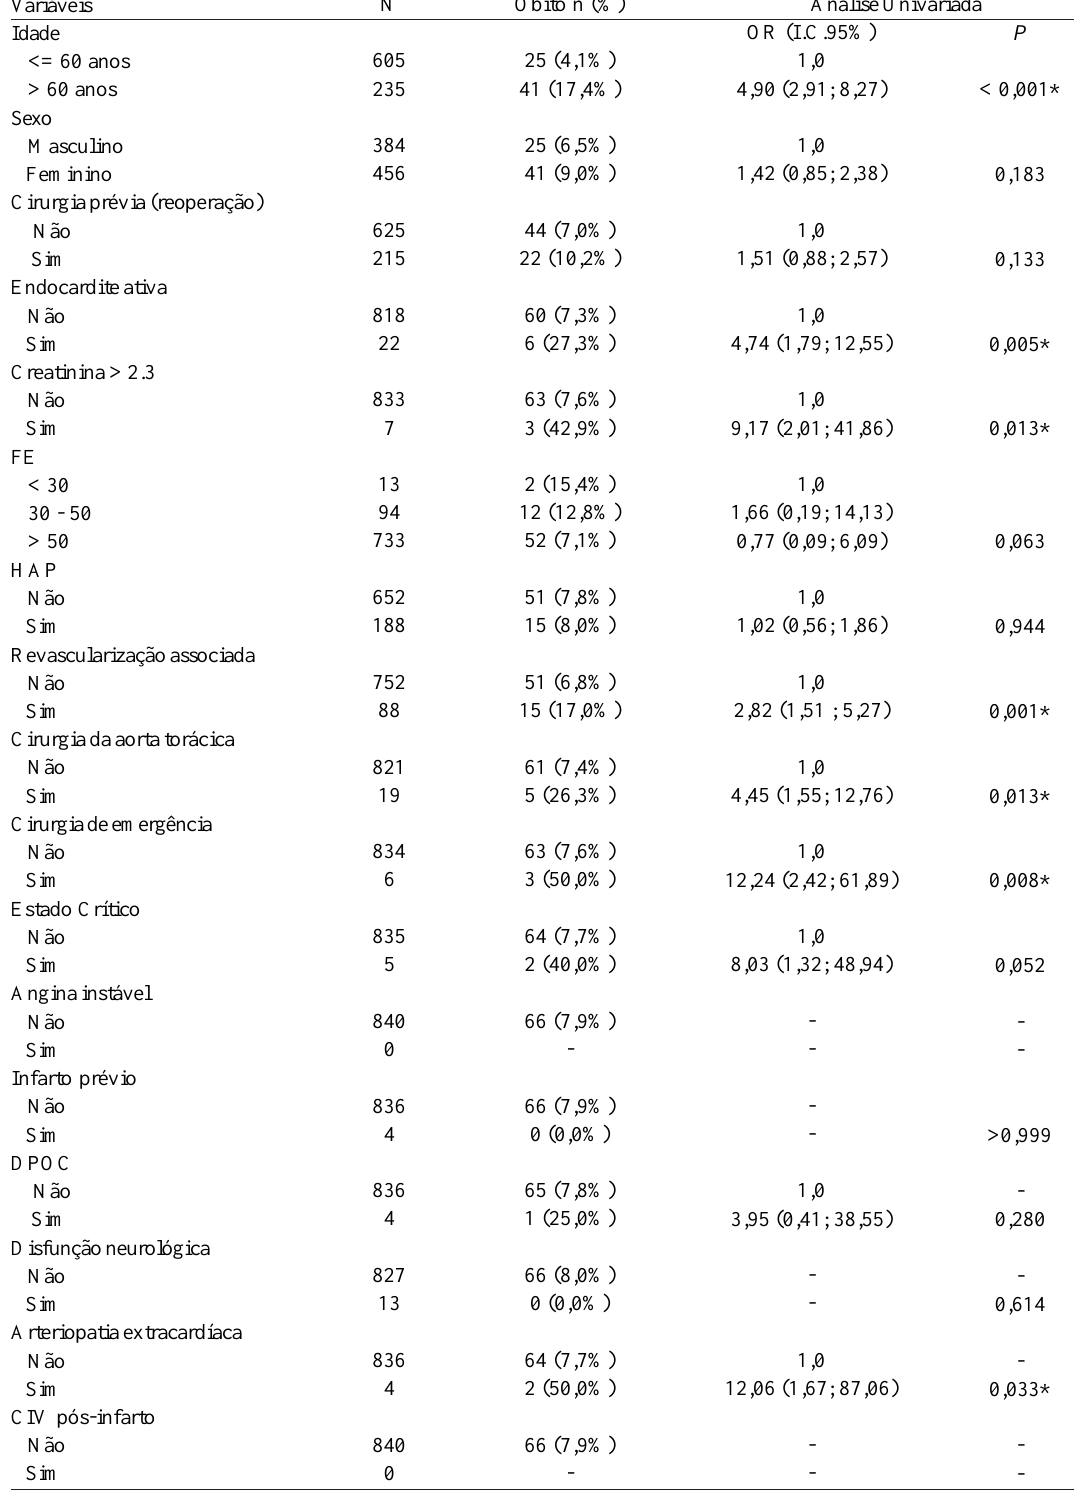
Tabela 9. Fatores associados com mortalidade hospitalar.